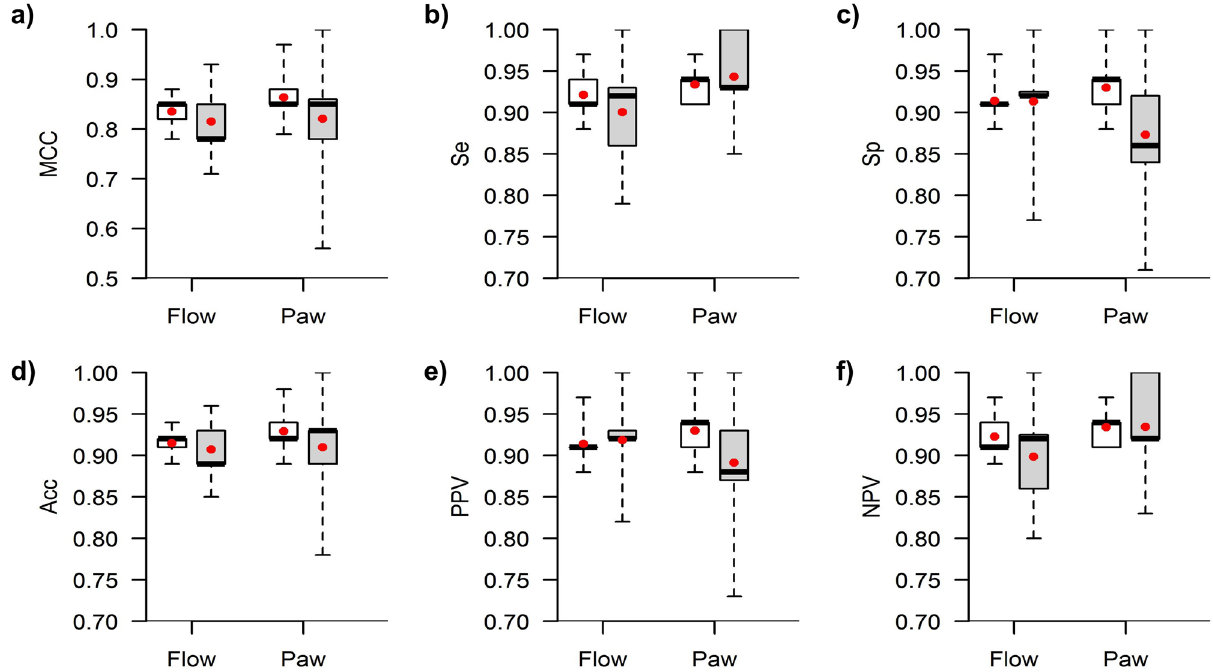
Figure 6. Performance statistics for SE -Flow max 25 ( m = 2 and r = 0.2) and SE -Paw max 30 ( m = 4 and r = 0.2) for detecting CP-VI. Boxplots of ( a ) Matthews correlation coefficient (MCC), ( b ) sensitivity (Se), ( c ) specificity (Sp), ( d ) accuracy (Acc), ( e ) positive predictive value (PPV), and ( f ) negative predictive value (NPV) from 15 repetitions during optimization (white) and 15 repetitions during validation (gray). The red dot represents the mean